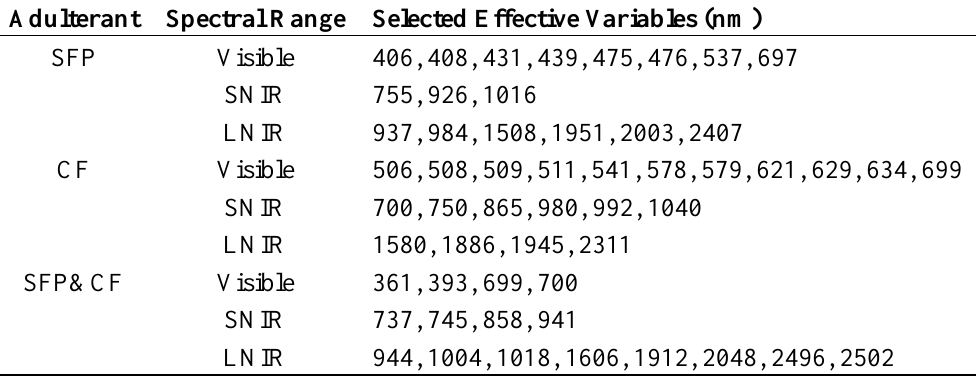
Table 3. Selected effective variables by competitive adaptive reweighted sampling (CARS) for visible spectra, short-wave near infrared spectra (SNIR), and long-wave near infrared spectra (LNIR) for the quantification of notoginseng powder (NP) adulterated by Sophora flavescens powder (SFP), corn flour (CF) and the mixture of two adulterants,